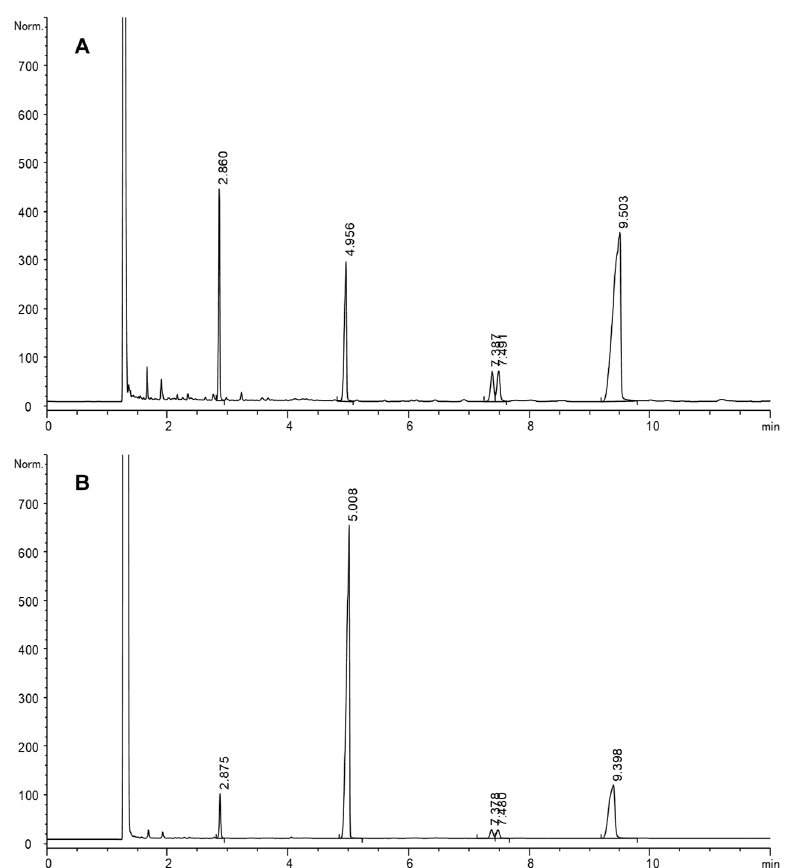
Figure 2. GC-FID chromatograms of a sample of methyl linoleate hydroperoxides (15.3 µ mol mL − 1 ) before ( A ) and after ( B ) simulated gastric digestion and both after reduction by hydrogenation. Re- tention times (min): 2.9, methyl stearate; 5.0, methyl heneicosanoate (IS); 7.4–7.5, methyl oxostearates, 9.4–9.5, methyl hydroxystearates. Chromatographic conditions: J&W DB ‐ Wax column, 230 °C.